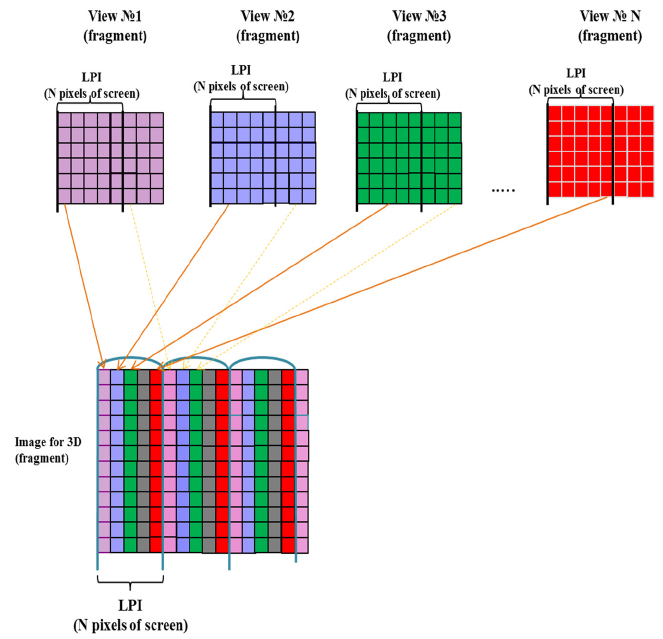
Figure 3. Schematic representation of 3D image file creation method. Adapted from [15].